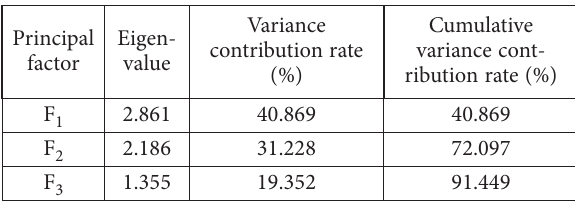
Table 3. Eigenvalues and variance contribution rate after